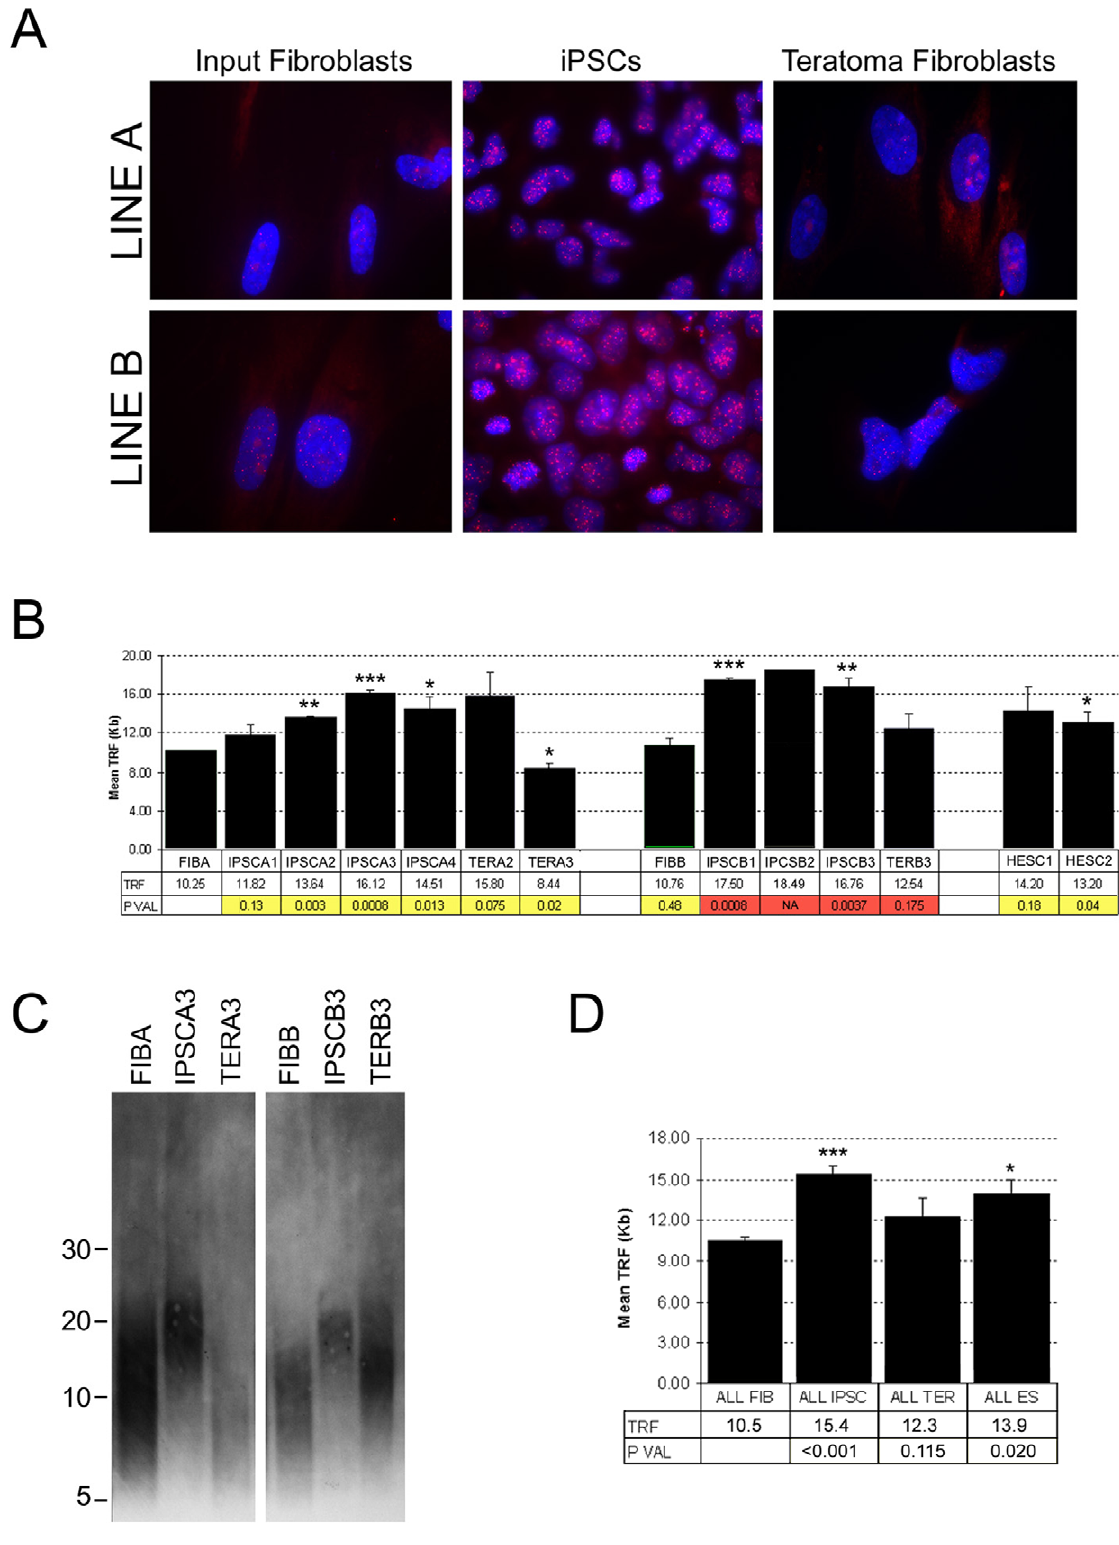
Figure 5. Analysis of telomeres in input, pluripotent, and re-differentiated cell lines. (A) Blue-stained nuclear DNA with punctate red fluorescence indicating telomeres hybridized to the PNA FISH telomere probe for input fibroblasts, IPSCs, or TER cells from lines A and B as labeled. mag. 400X. (B) Quantification of TRFs from cell lines as labeled. Yellow shading indicates significance compared to line FIBA and red shading significance compared to line FIBB. TRF indicates mean length in kilobase pairs (Kb). *=P , 0.05, **=P , 0.01, ***=P , .001. Error bars indicate SEM. (C) Example of changes in TRF size in cell lines as labeled. Numbers at left are fragment lengths in kilobases. (D) Mean TRF lengths for all cell lines combined by type. Labeling as in part B. Significance calculated relative to FIB.